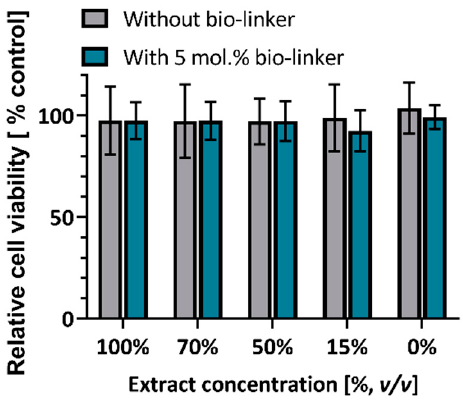
Figure 2. Results of the in vitro MTT cytotoxicity tests presented with mean value and standard deviation (at least three repeats) for different extract concentrations from 100% v / v to 0% v / v of the tested material. The tested materials were pHEMA samples with 0.7 mol.% EGDMA, without bio- linker (grey), and with 5 mol.% bio-linker (blue). Cell viabilities were above 90% for all tested sam- ples.